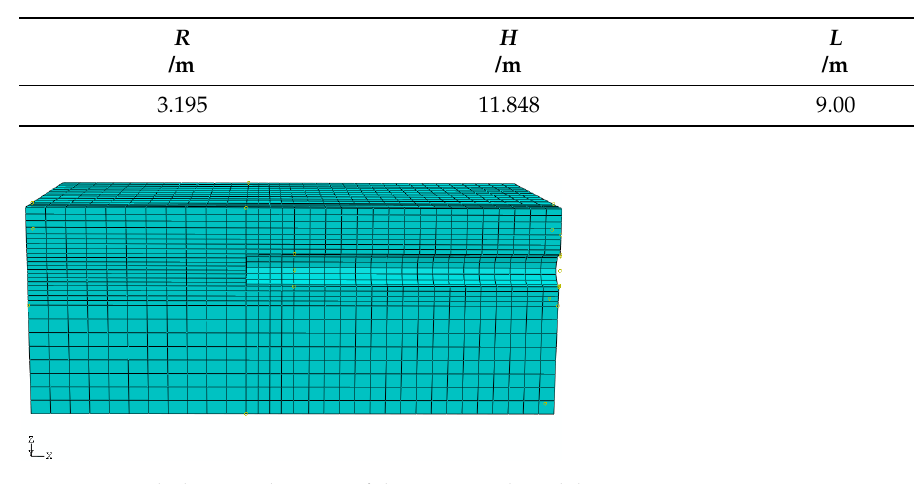
Figure 9. Mesh division diagram of the computed model. Table 9. Computing parameters of soil for the analytical method.